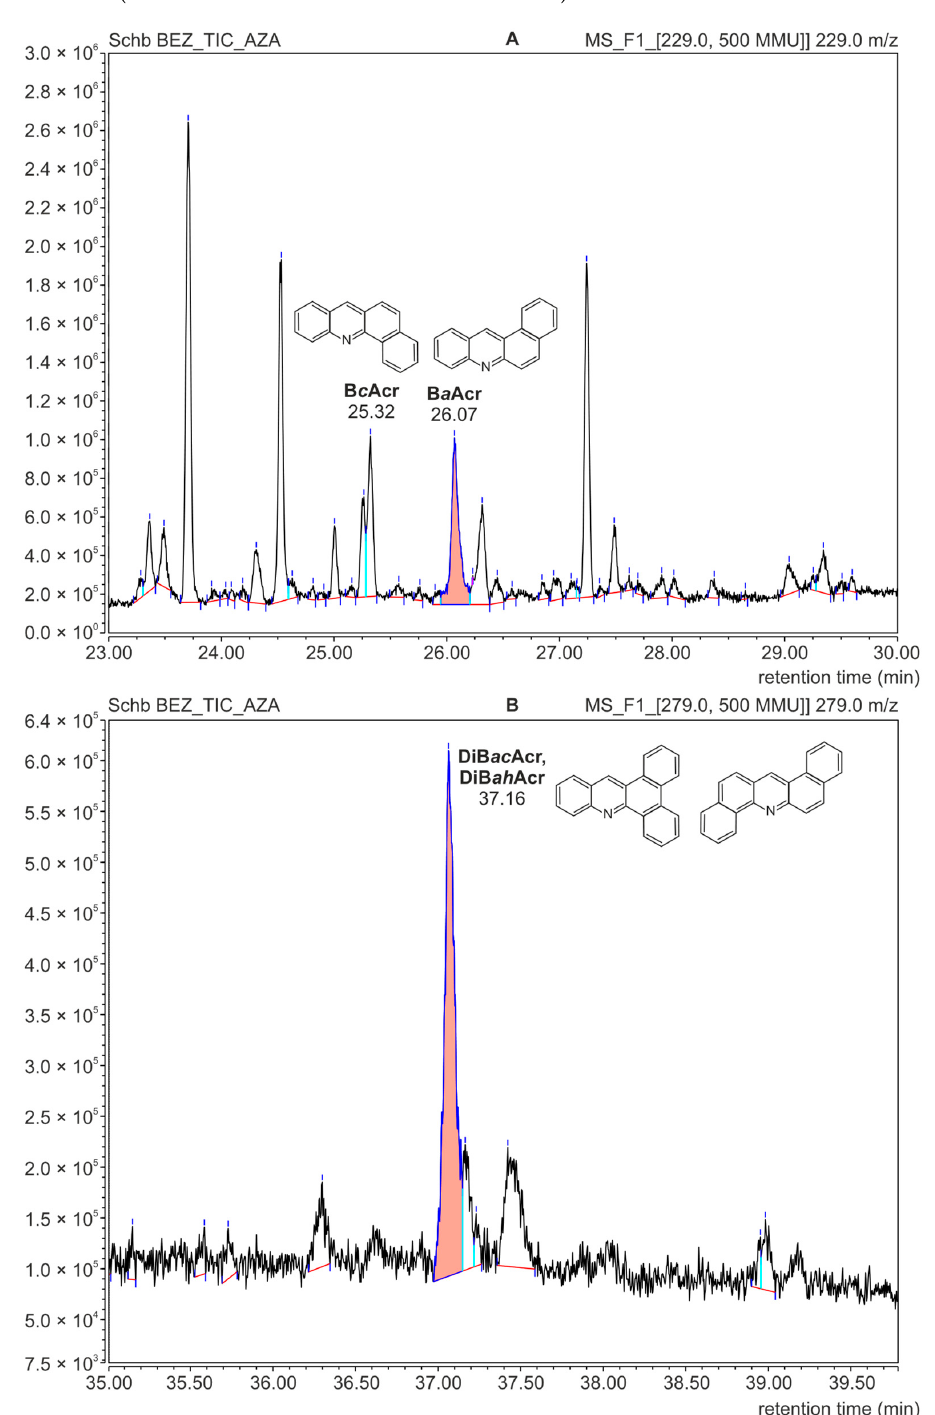
Figure 5. GC-MS mass chromatograms of the azaarene fraction separated from a roasted meat sample without additives; ( A ): recorded for the molecular mass of benzoacridines (m/z = 229); ( B ): recorded for the molecular mass of dibenzoacridines (m/z = 279).